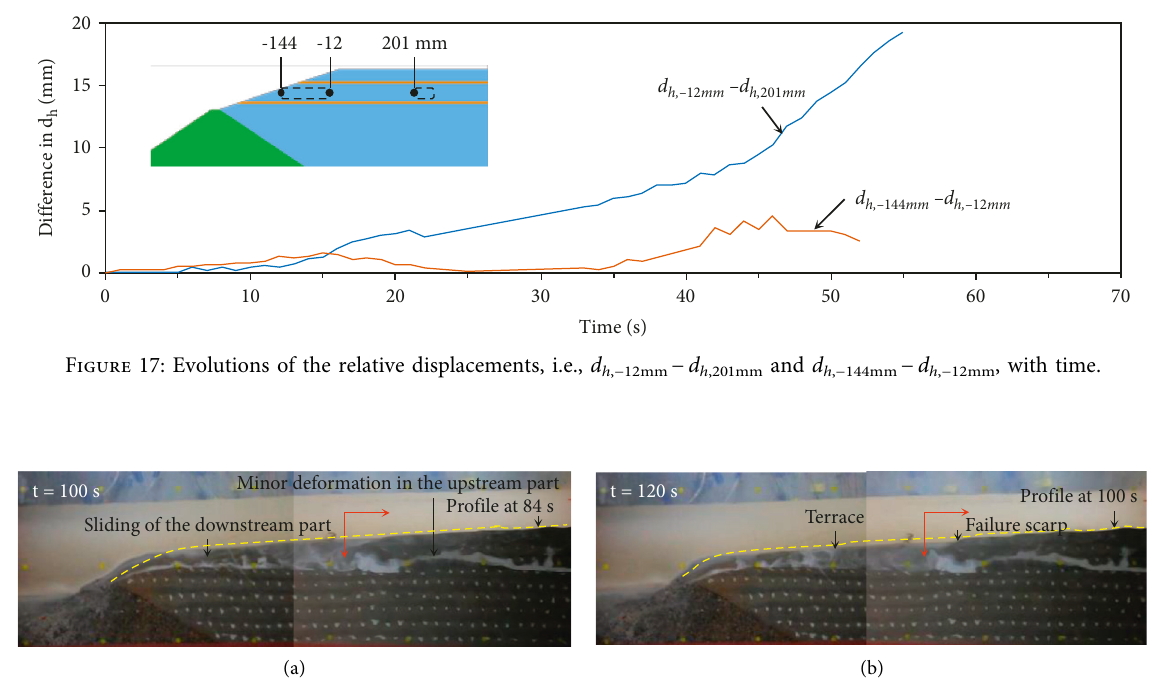
Figure 18: Snapshots of the tailings impoundment during stage 4: (a) t � 100s and (b) t � 120